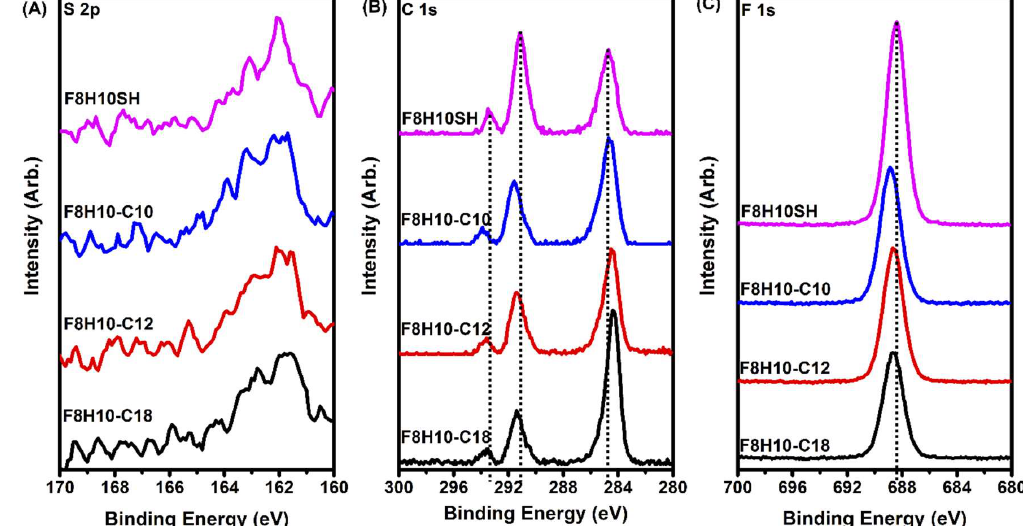
Figure 3. X-ray photoelectron spectroscopy (XPS) spectra collected from SAMs derived from F8H10SH and F8H10-Cm (m = 10, 12, and 18) for the ( A ) S 2p; ( B ) C 1s; and ( C ) F 1s regions.